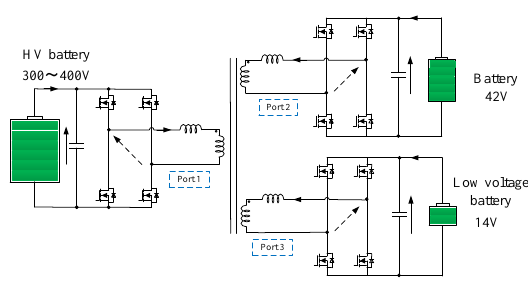
Figure 19. DC-DC converter in EVs application using the TAB converter.